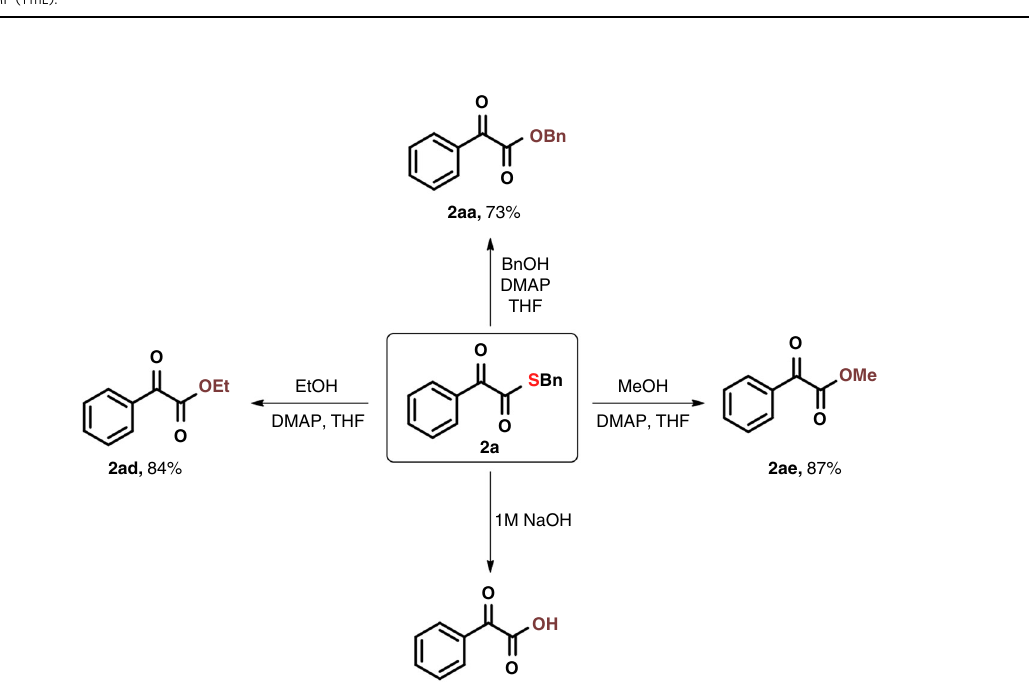
Fig. 4 Further transformations. Dicarbonylation of alcohols and